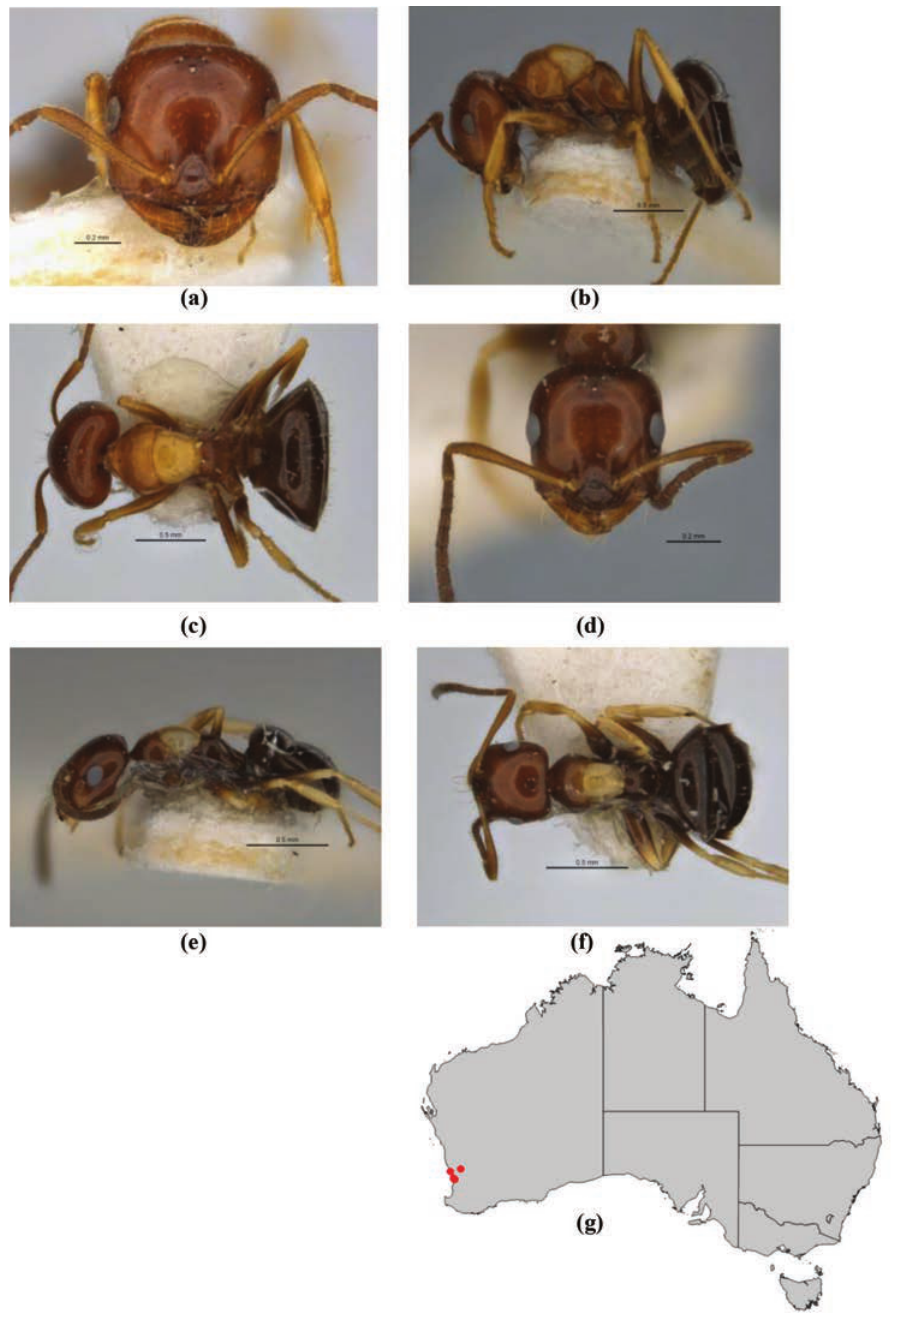
Figure 94. Melophorus translucens sp. n.: major worker paratype (JDM32-001966–top ant) frons ( a ), profile ( b ) and dorsum ( c ); minor worker holotype (JDM32-001966–bottom ant) frons ( d ), profile ( e ) and dorsum ( f ); distribution map for the species ( g ). Low resolution scale bars: 0.5 mm ( b, c , e, f ); 0.2 mm ( a, d